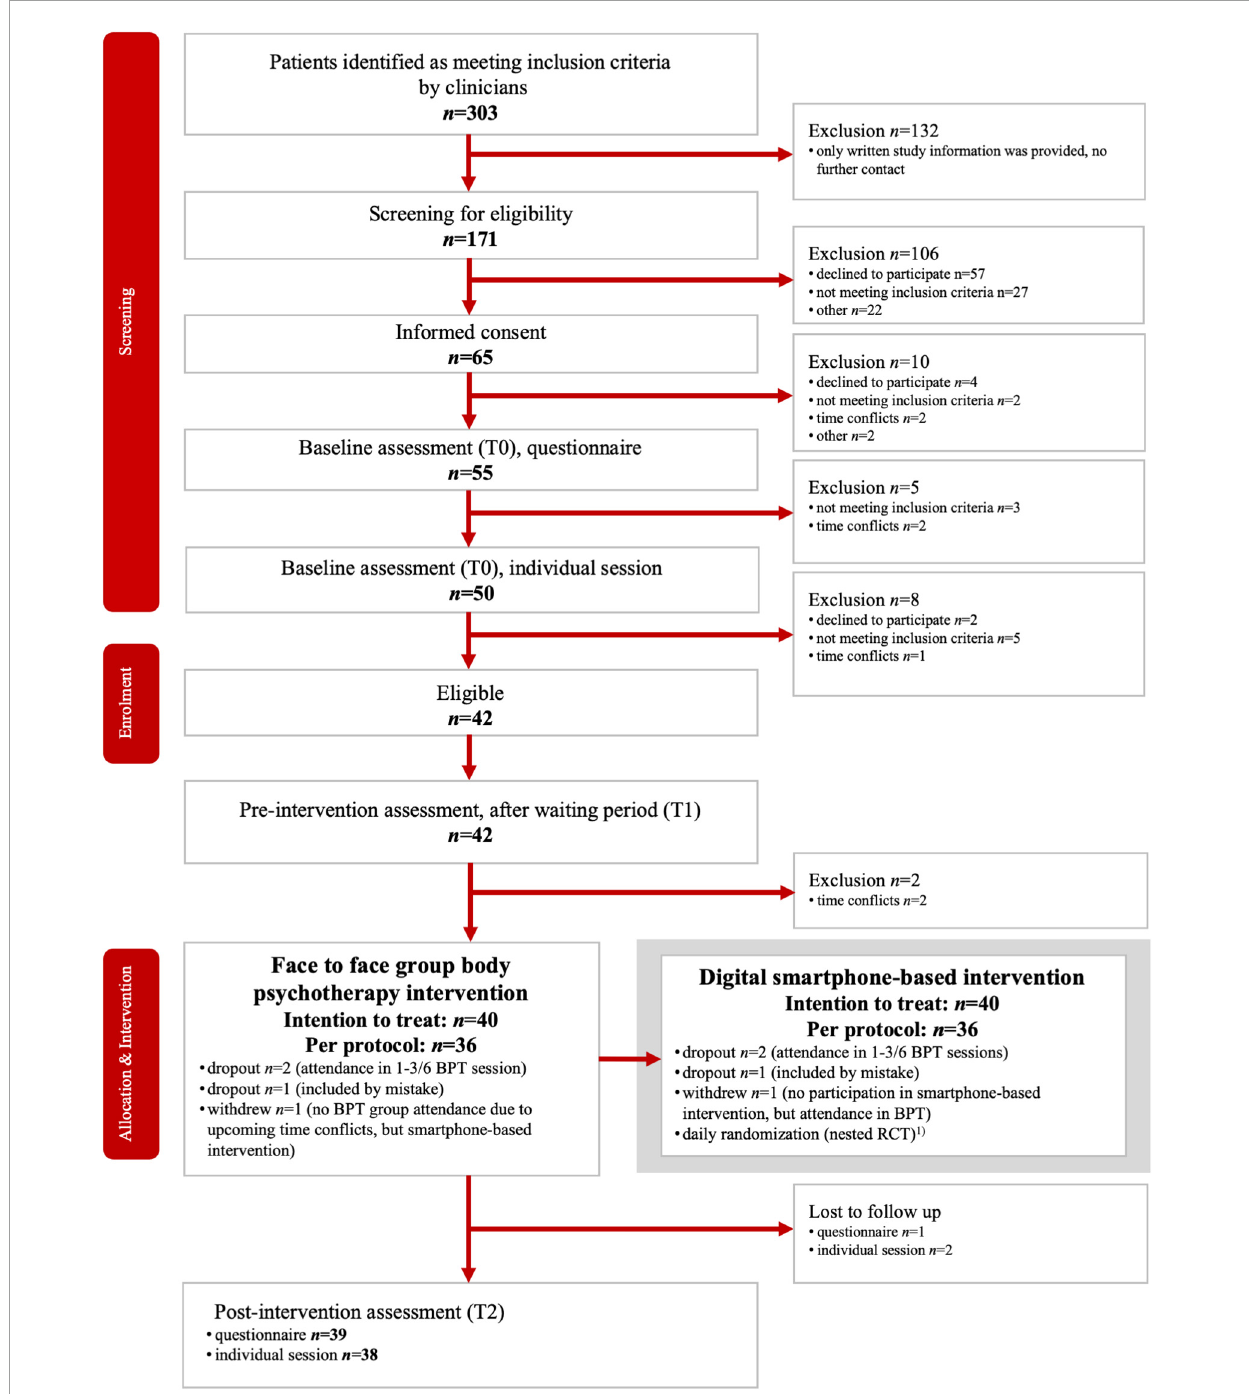
FIGURE1 Study flow-chart. The smartphone-triggered bodily and control interventions were provided over a period of 5 consecutive weeks on 6 days per week, in parallel to the BPT sessions. Thus, each patient underwent 15 bodily and 15 control interventions. The results are not part of this paper and will be reported